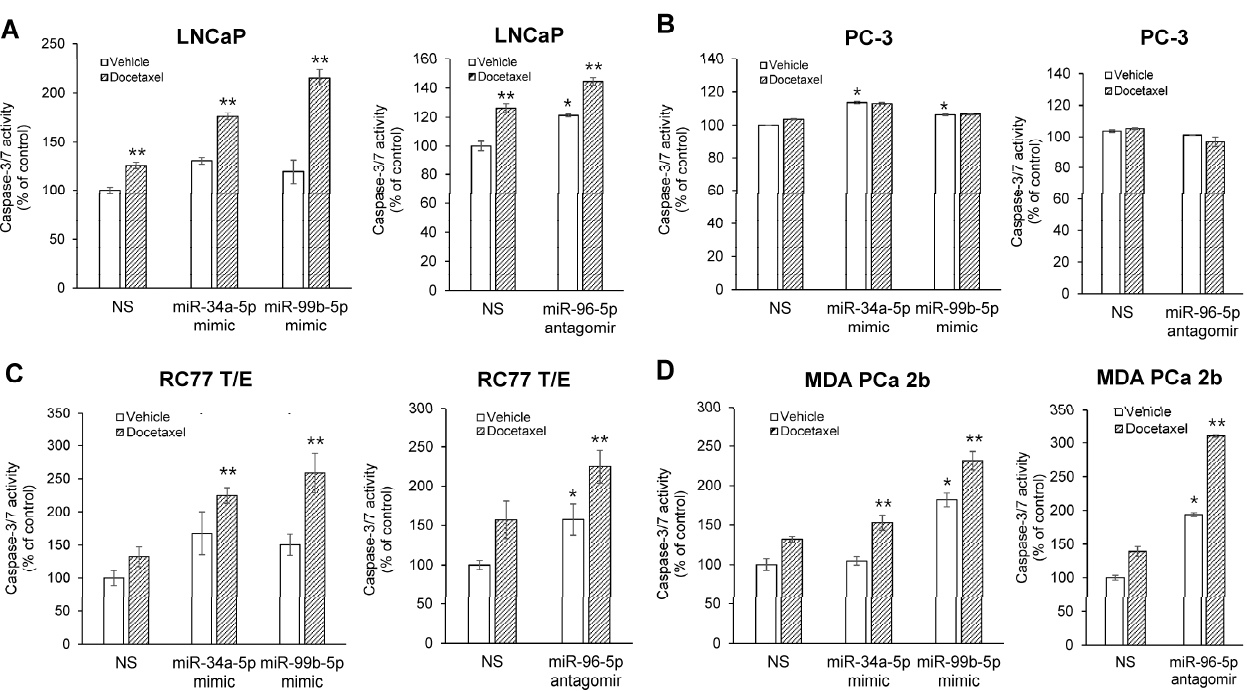
Figure 8. Overexpression of miR-34a-5p mimic, miR-99b-5p mimic or miR-96-5p antagomir enhances docetaxel-induced cytotoxicity in EA PCa ( A , B ) and AA PCa ( C , D ) cell lines. Apoptosis activity was assessed by measuring caspase-3/7 activity using the Apo-ONE Kit, and the data were normalized to caspase-3/7 level of vehicle-treated NS control. Data were plotted as mean ± SEM for n of 3–4 independent experiments, with technical triplicates for each independent experiment. The significance (* p < 0.05 in miRNA mimic or antagomir transfection plus vehicle treatment vs. NS plus vehicle treatment, and ** p < 0.05 in miRNA mimic or antagomir transfection plus docetaxel treatment to miRNA mimic or antagomir transfection with vehicle treatment) was determined using ANOVA with Tukey post hoc test.